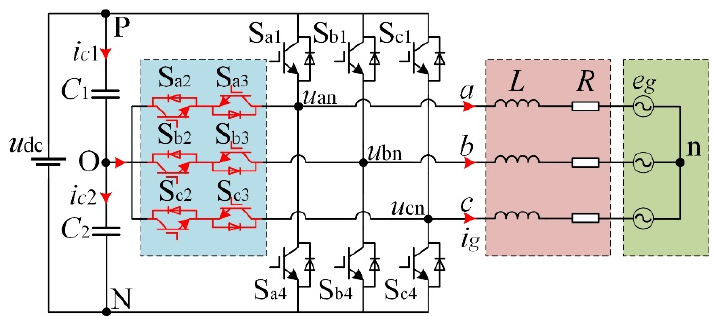
Figure 1. Topology of the T-type three-level grid-tied inverter.